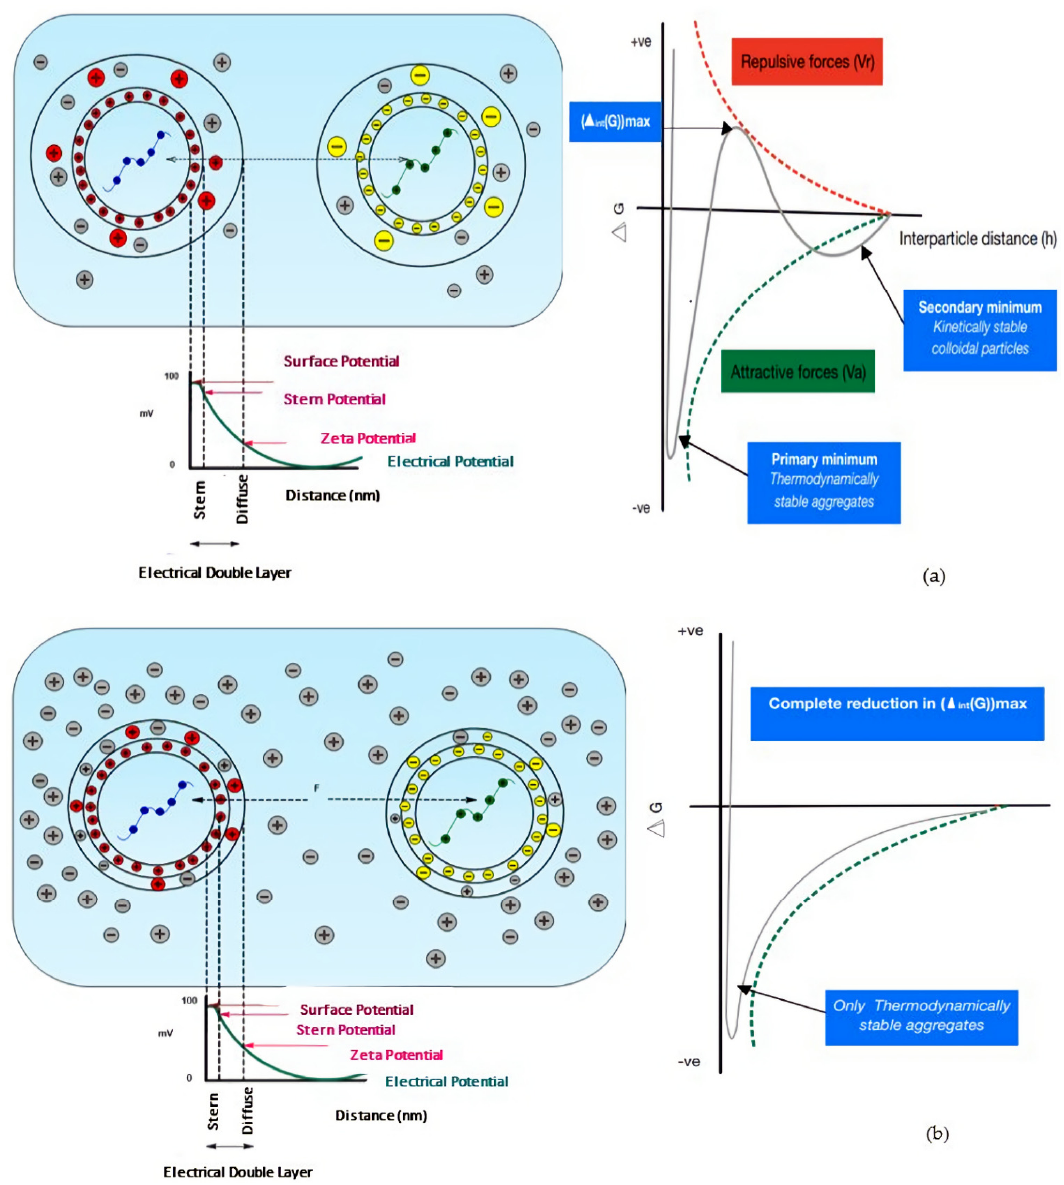
Figure 4. The complexation of two polyelectrolytes of opposing charges under low – ( a ) and high – ( b ) ionic – strength conditions. The effect of both low and high ionic strength on colloidal stability is also represented by the energy vs. interparticulate distance graph drawn per DLVO theory (Red (+)—cations within the electrical double layer (EDL) of HA that are strongly attracted to the anionic carboxylate groups. Yellow ( − )—anions within the EDL of the cationic polyelectrolyte that are strongly attracted to the cationic groups. Grey (+/ − )—counterions within and outside the EDL of the polyelectrolytes that are more weakly attracted to the surface charges).